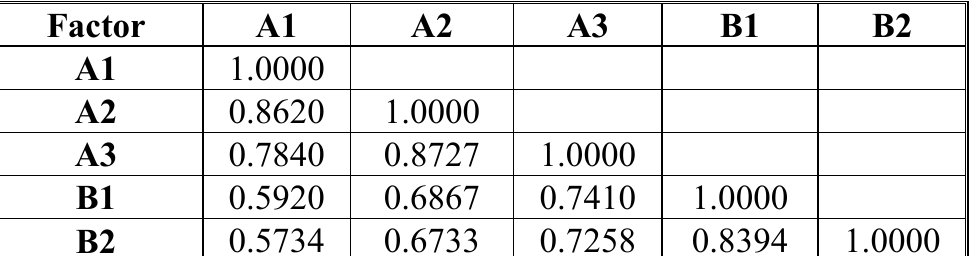
Pearson product-moment correlation coefficients: Section